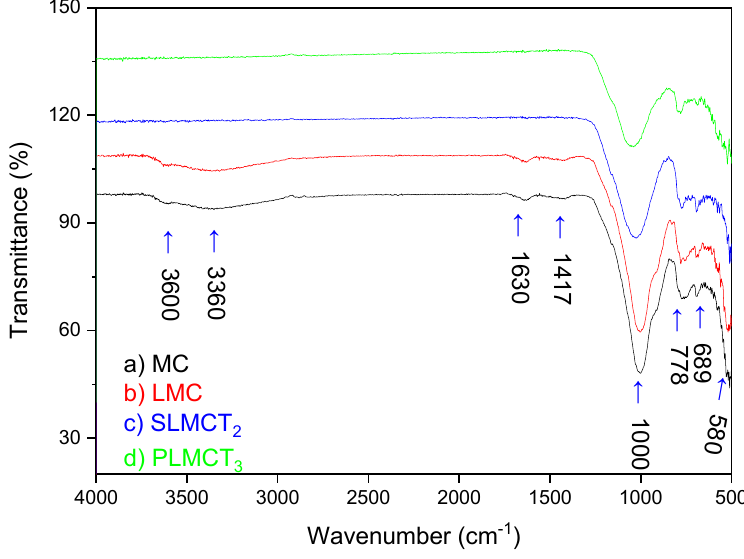
Figure 3. FTIR spectra of the adsorbents: ( a ) raw muscovite MC, ( b ) iron/manganese muscovite/so- dalite LMC, ( c ) monolith muscovite/analcime SLMCT 2 and ( d ) pellets muscovite/analcime compo- sites PLMCT 3 .